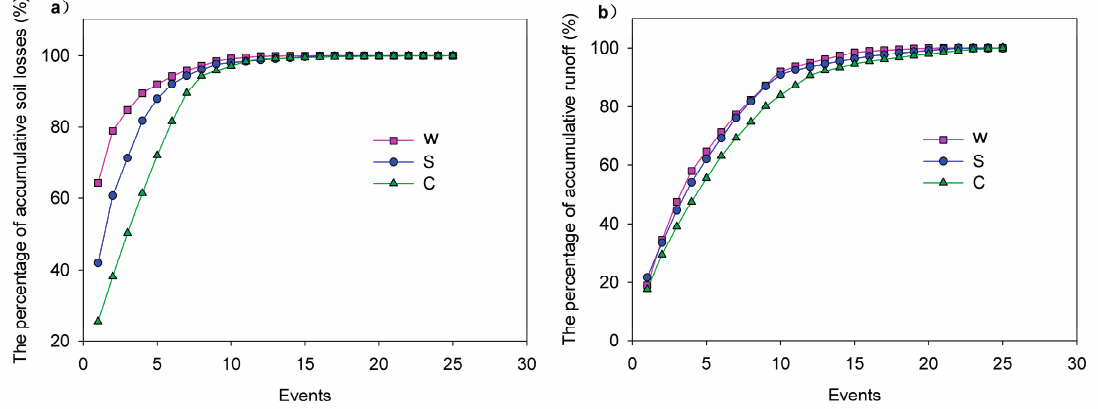
Figure 4. The percentage of accumulative soil loss ( a ) and runoff ( b ) in relation to the number of events from 2010 to 2013 (the events were independently ranked from largest to smallest for soil loss and